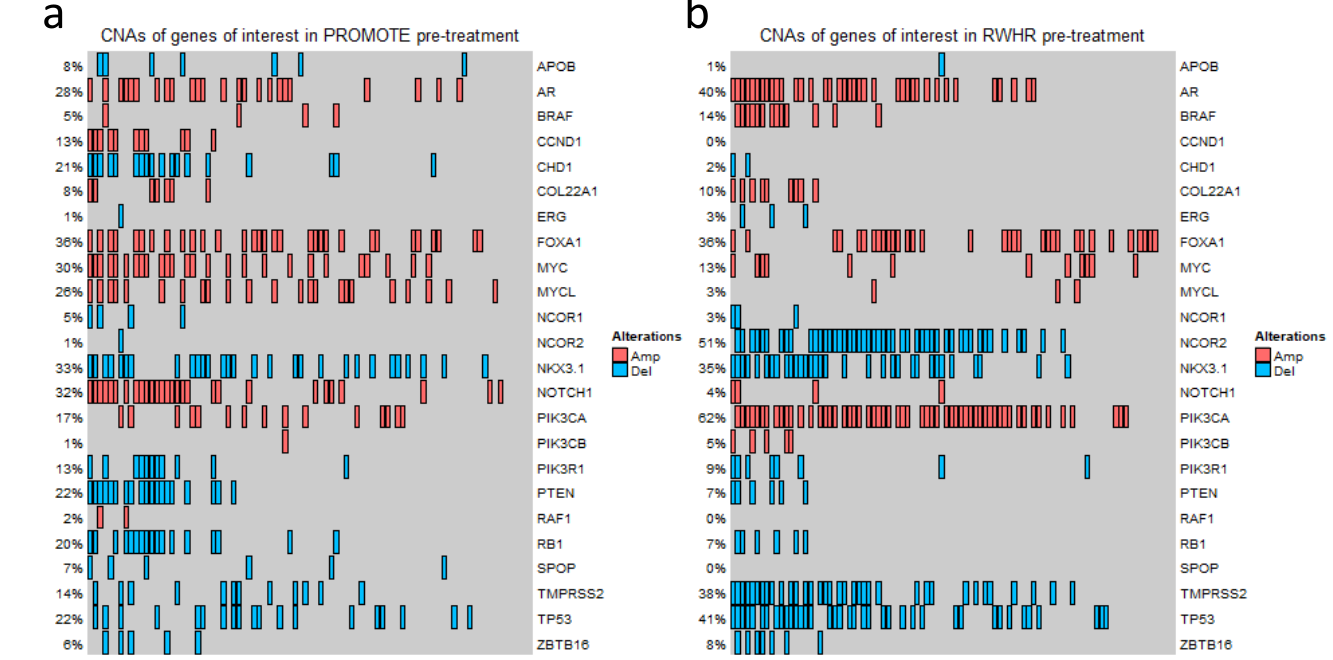
Figure 1. Copy number variation status of the genes of interest. OncoPrint Figure showing CNA status at 24 gene loci in the PROMOTE ( a ) and RWHR ( b ) cohorts. Each column represents an individual mCRPC patient. The percentage value indicates the CNA frequency of a gene. Red rectangle represents gain (log2 copy number ratio > 0.3). Blue rectangle represents loss (log2 copy number ratio < −0 .3).